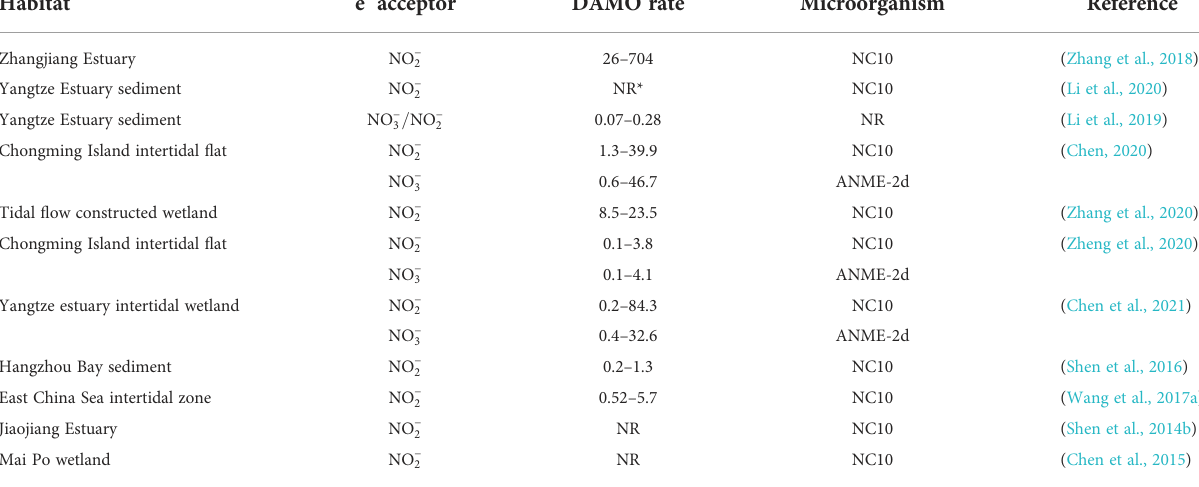
TABLE 4 Nitrite- and nitrate-dependent DAMO rates and microorganisms in coastal habitats. Habitat e - acceptor DAMO